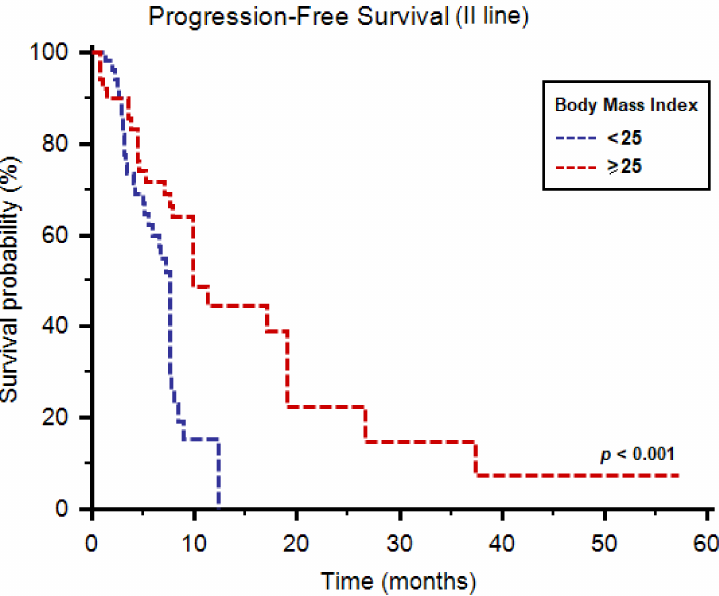
Figure 1. Progression-free survival of patients receiving cabozantinib as second-line therapy stratified by body mass